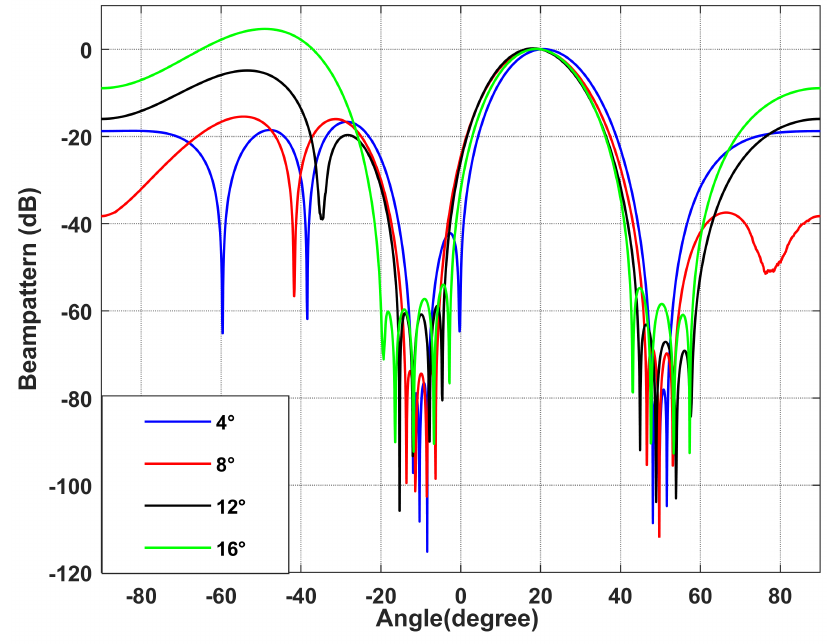
Figure 7. Beamforming diagram with different null broadening angles. Simulation 3.